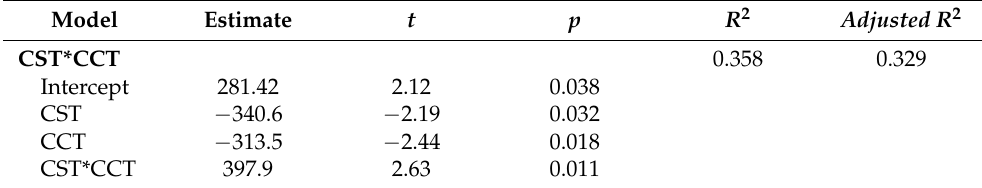
Table 2. Multivariate model of the upper extremity motor recovery in all participants.